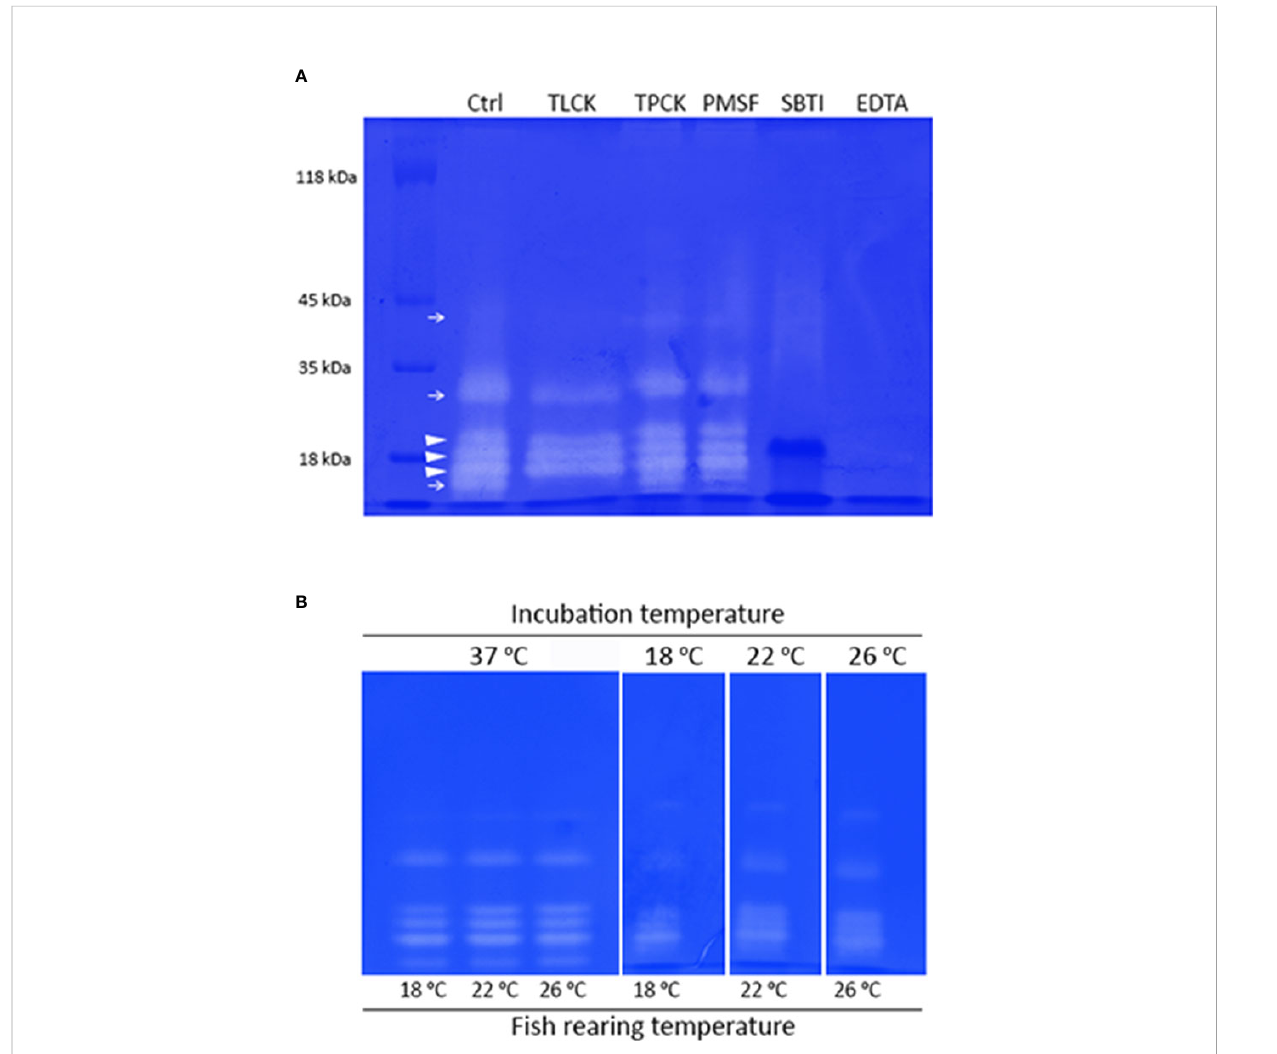
FIGURE 7 (A) 13% substrate SDS-PAGE showing caseinolytic activity bands in a pool containing pyloric caeca extracts of S. dumerili adapted to different rearing temperatures (18, 22 and 26°C) (Ctrl) and inhibition by speci fi c inhibitors for trypsin (TLCK), chymotrypsin (TPCK), serine proteinases (PMSF and SBTI) and metalloproteases (EDTA). Type of proteases is indicated in the control lane as follows: trypsin like proteinases ( ! ) and chymotrypsin like proteinases ( ► ). (B) 13% substrate SDS-PAGE showing caseinolytic activity bands in independent pools of pyloric caeca extracts of S. dumerili from each rearing temperature (18, 22 and 26°C) and incubated at 37°C or at the temperature the fi sh providing each sample was adapted to (18, 22 and